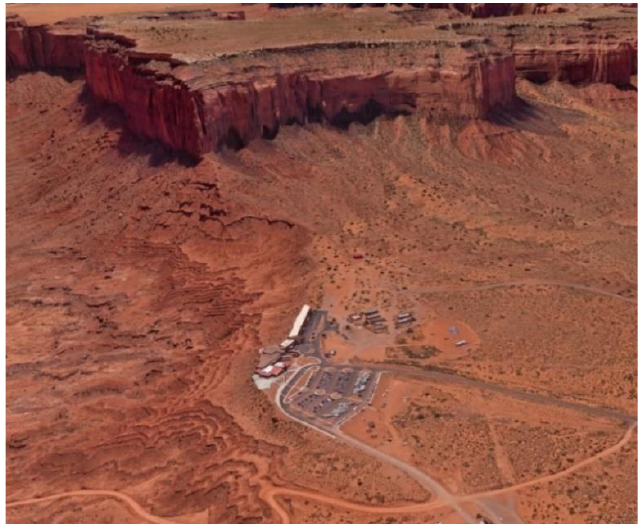
Figure 10. Monument Valley Navajo Tribal Park visitor centre: the luxury hotel (from Google Earth Pro V 7.3.4 (5 May 2022), 36°58′55.91″N, 110°06′42.21″W, Eye alt 2.72 km, Landsat, Copernicus, Maxar Technologies 2022, [46]).